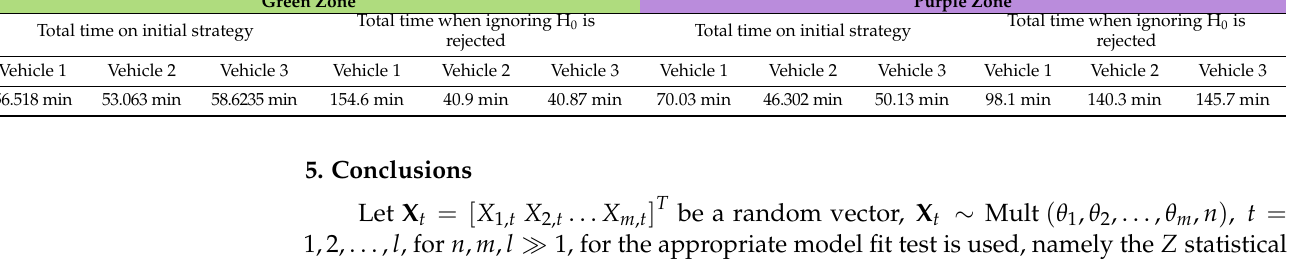
Table 5. The risks when ignoring H 0 is rejected (for the green zone and purple zone). Green